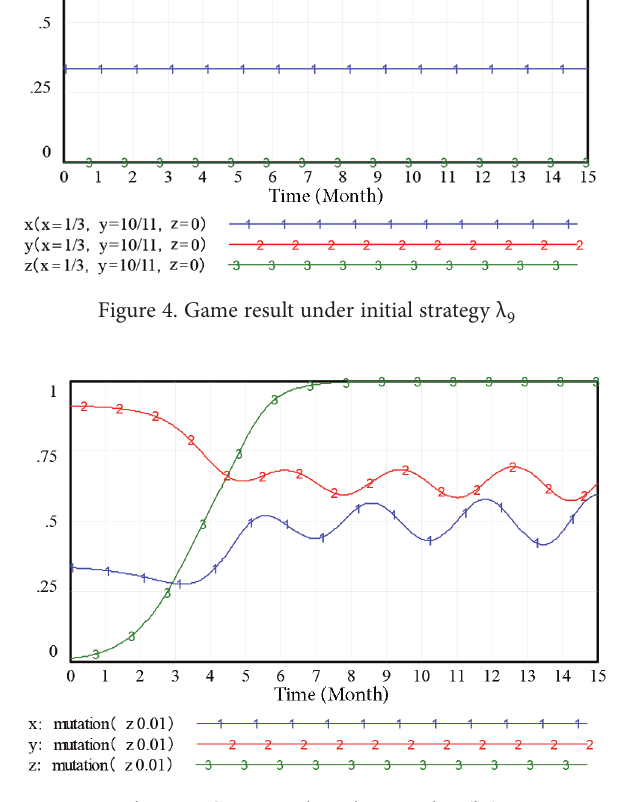
Figure 7. Game results under penalty increase for CC ( P b